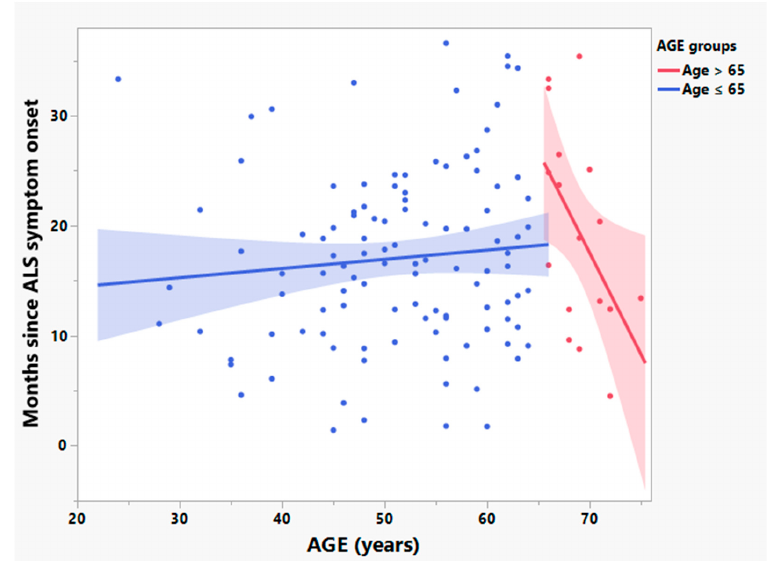
Figure 4. Among ALS patients in the phase 2A NP001 trial, duration of ALS symptom onset differed by age group ( ≤ 65 or >65 years old). Bivariate linear fit was used for the linear regression analysis. A negative relationship between the log transformed ALS disease duration (time since ALS symptom onset to baseline) and age was observed in the participants > 65 years old (R 2 : 0.27, p = 0.03, n =17, depicted in red). No linear association between age and ALS disease duration was found in those ≤ 65 years old (R 2 = 0.01, p = 0.32, n = 108, depicted in blue).